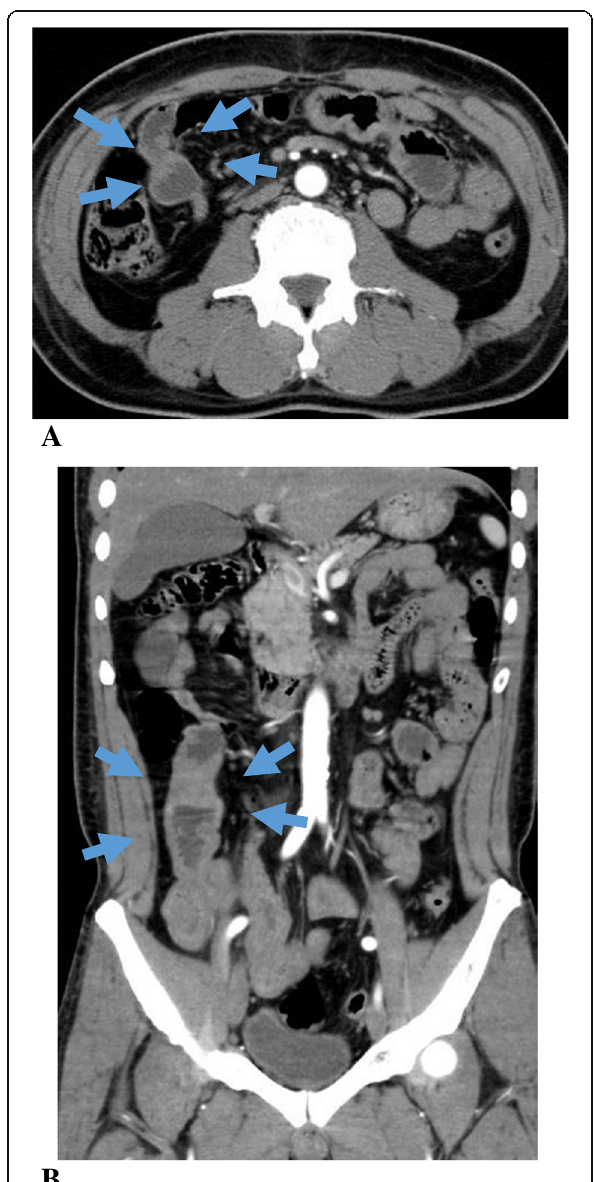
Fig. 1 Contrast-enhanced abdominal computed tomography shows thickening of the small bowel wall. a Axial view. b Coronal view